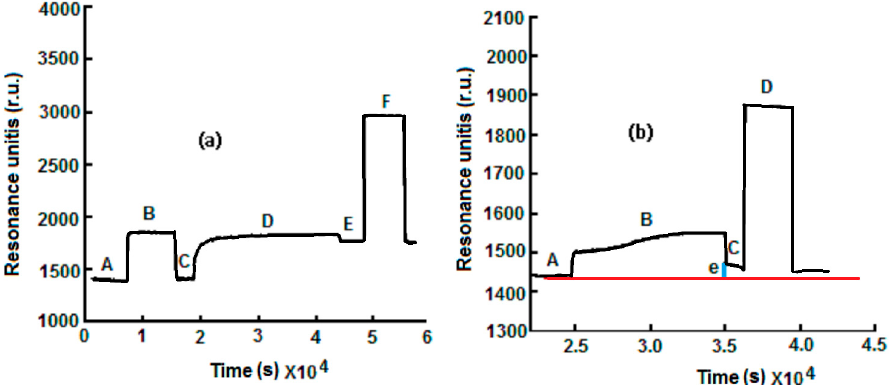
Figure 2. ( a ) Immobilization of anti-ampicillin: (A) baseline obtained after rehydratation of the self-assembled monolayer (SAM); (B) activation with 1-ethyl-3-(3-dimethyl-aminopropyl) carbodiimide (EDC)/N-hydroxysuccinimide (NHS) (EDC/NHS); (C) washing with buffer solution; (D) immobilization of 0.5 g·L − 1 anti-ampicillin; (E) washing with buffer solution; (F) inactivation of non reacted –COOH groups with ethanolamine; (e = Δ in r.u.). ( b ) Example of response of anti-ampicillin SPR immunosensor towards ampicillin.